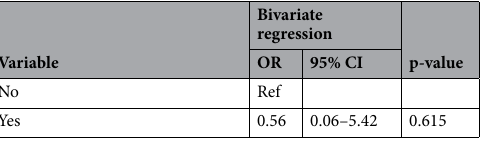
Table 5. Factors associated with external ocular and periocular infections among a Ghanaian ophthalmic population. Bivariate regression analysis at a significance of p < 0.05. OR odds ratio, CI confidence interval, Ref